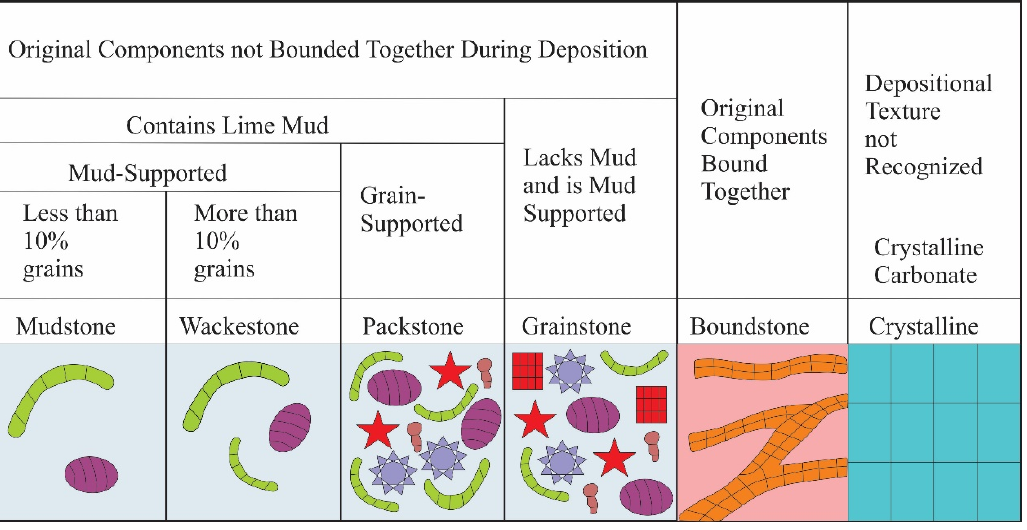
Figure 3. Representing the Dunham classification of limestone based on depositional texture.